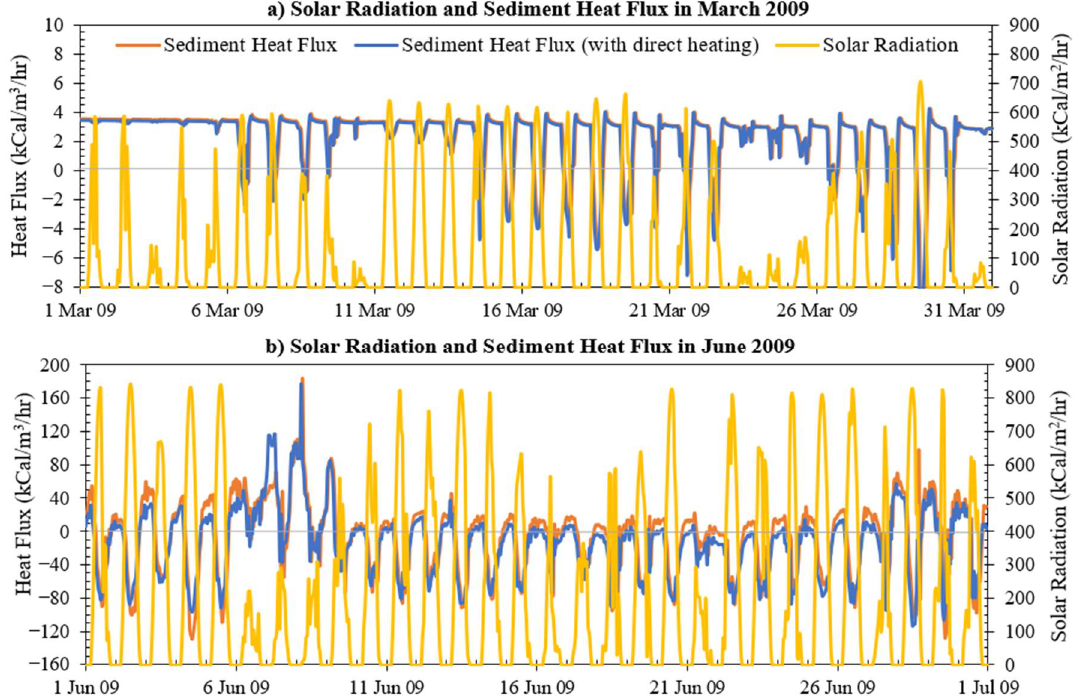
Figure 9. Sediment heat flux distribution in ( a ) March 2009 and ( b ) June 2009 in Carrie Lake.